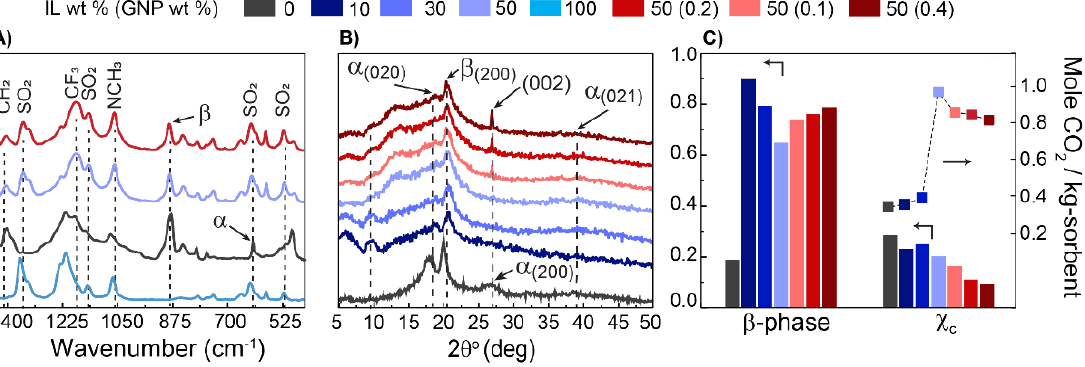
Figure 5. ( A ) Fourier-transform infrared spectroscopy (FTIR) fingerprint of polymer, IL, and two different mixtures cast on QCM substrate. ( B ) X-ray diffractograms of films cast from different mixtures. ( C ) The degree of β -phase and crystallinity of the samples and the normalized CO 2 absorption capacity of thin films for a sample tested at 200 psi and 313.15